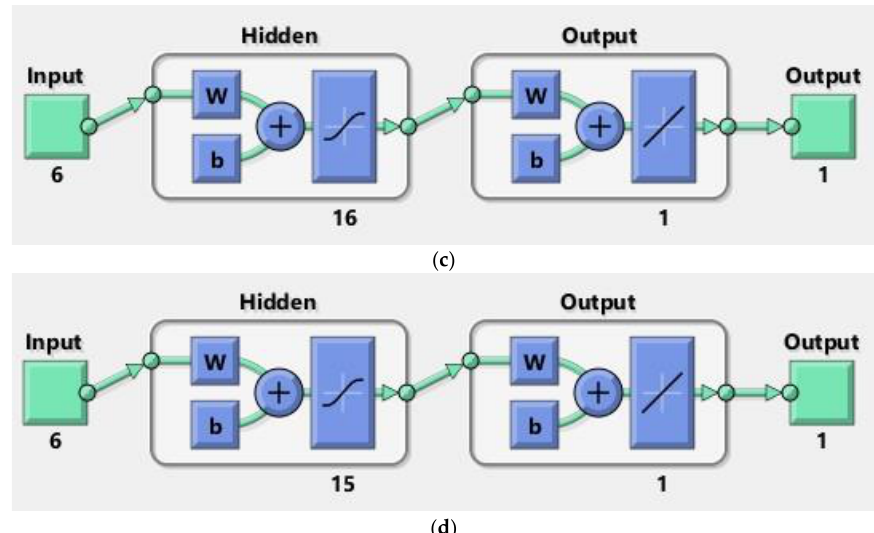
Figure 2. ( a ) Structural topology of ANN model without heat generation effect. ( b ) Structural topology of ANN model with heat generation effect. ( c ) Structural topology of ANN model without radiation effect. ( d ) Structural topology of ANN model with radiation effect.